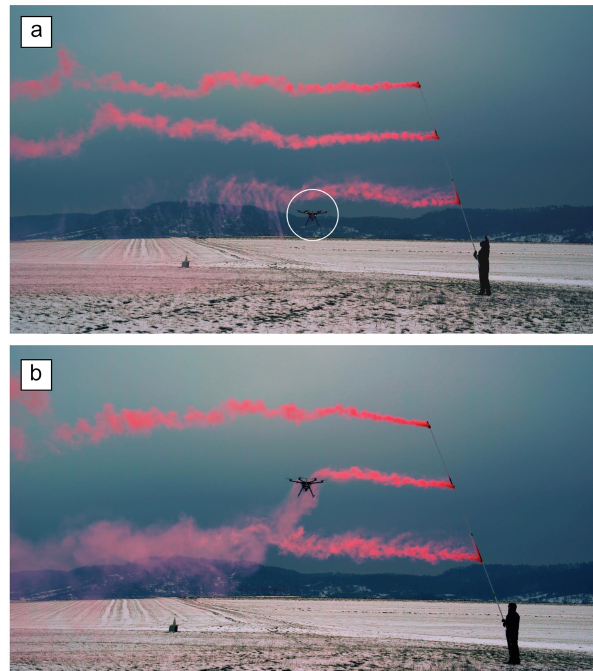
Figure 6. Investigation of the airflow pattern caused by the multi- copter UAV (DJI S900) using three coloured pyrotechnical smoke cartridges with (a) flying the multicopter UAV below the lowest smoke plume, and (b) below the middle smoke plume; screenshots taken from a 30s video sequence. Side wind from right to left. Di- lution of the smoke plume and thus mixing of the surrounding air occurs essentially only on the lee side and below the multicopter UAV, while in windward and above the multicopter UAV, the ap- proaching plume remains largely unaffected.